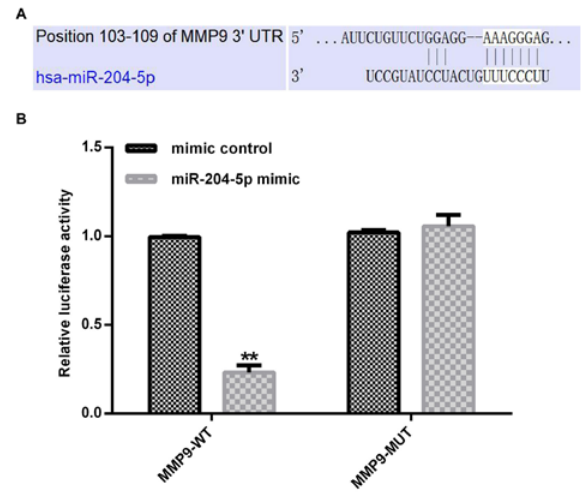
Figure 2: miR-204-5p directly targets MMP-9. (A) The position of miR-204-5p target sites in 3′-UTR of MMP-9. (B) Dual-luciferase assay was used to confirm the binding sites between miR-204-5p and MMP9. Each value represents as means ± SD. **p <